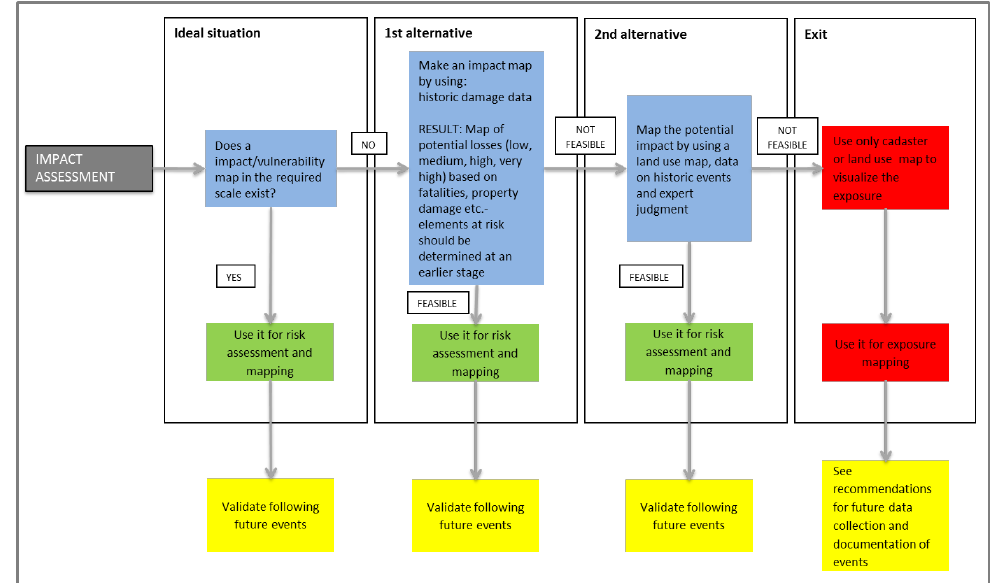
Figure 6. Qualitative impact assessment using alternative steps [46].